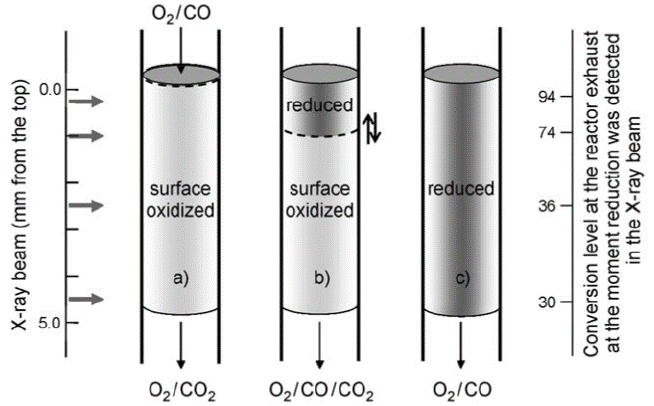
Figure 13. A schematic summary of the results derived in [152] and pertaining to Figure 12.